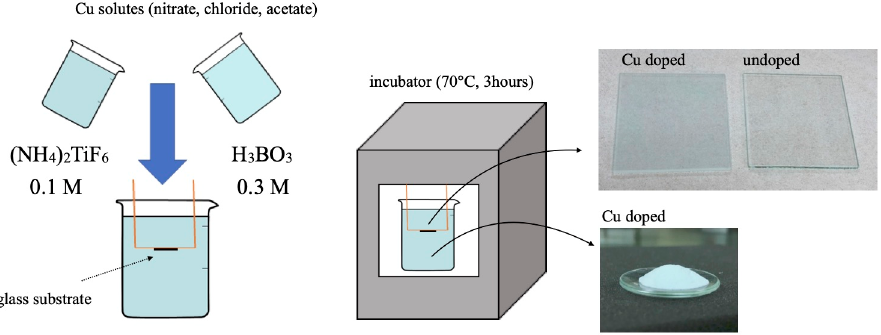
Figure 1. Schematic illustration of experimental procedure for producing Cu-doped TiO 2 powders and coatings via liquid phase deposition.